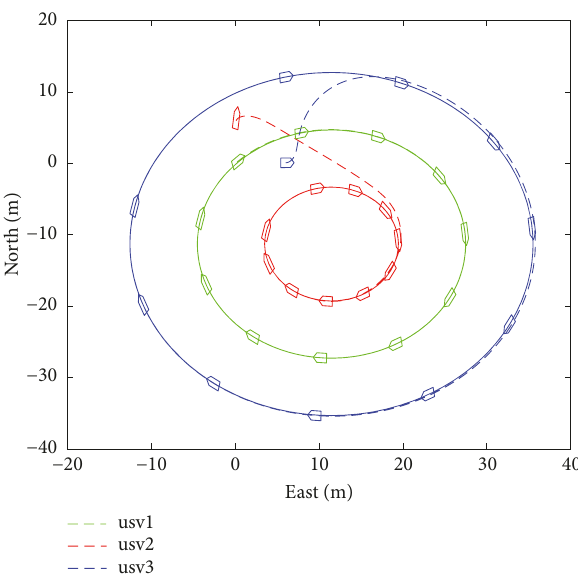
Figure 7: The USV motion curve of straight line formation.